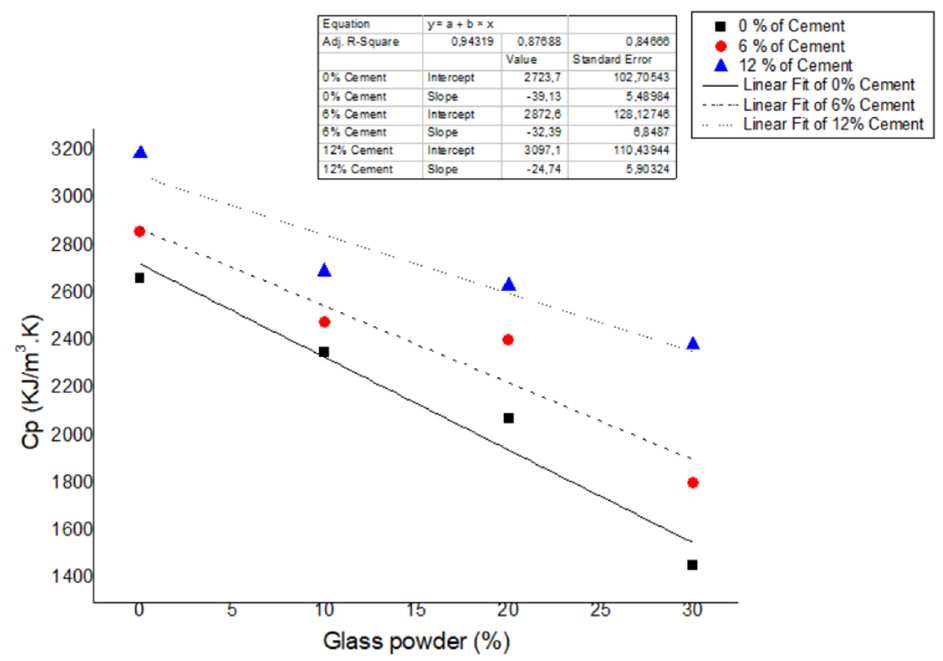
Figure 10. Variation of the measured mortars specific heat capacity in the dry state as a function of the glass powder content.